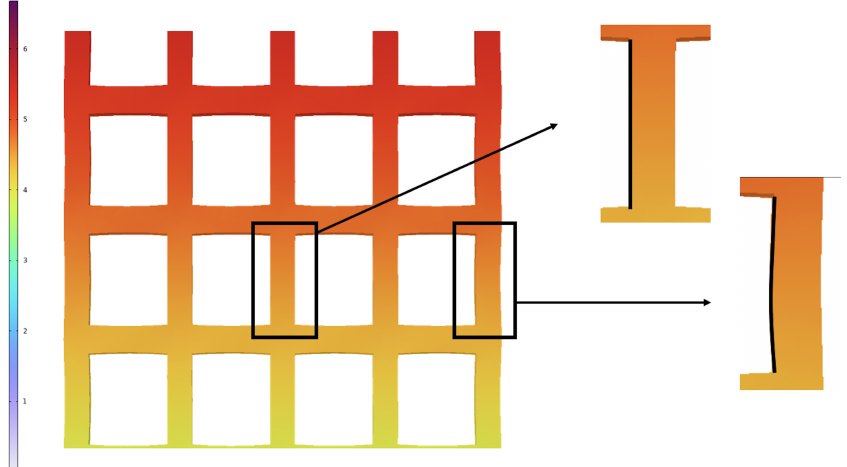
Figure 7. Representative image of the middle part of the square membrane during the simulation of the tensile test where deformations can be